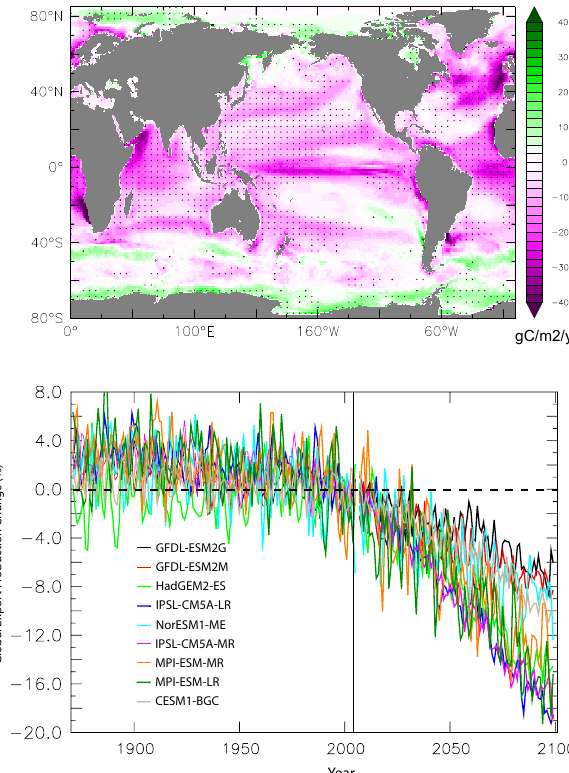
Fig. 9. Change in export production of organic particles at 100m un- der RCP8.5. (a) Multi-model mean change of export production in 2090–2999 relative to 1990–1999 (%). Stippling marks robustness from agreement on sign of changes. (b) Time series for all models of the change of export production relative to 1990–1999 (%) from 1870–2099 using historical and RCP8.5